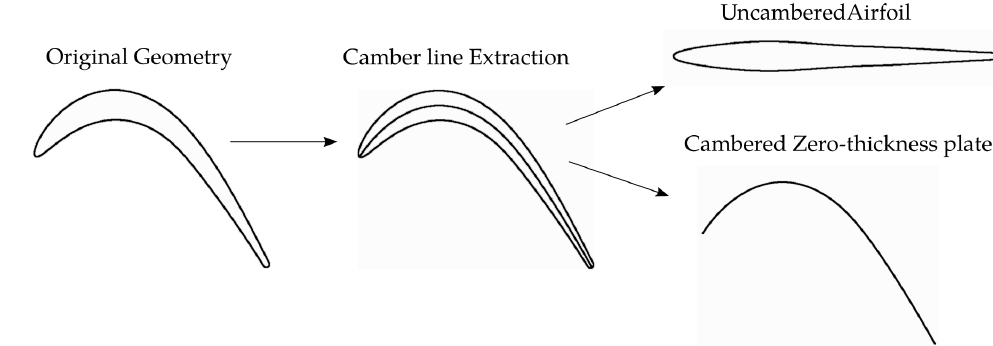
Figure 7. Extraction of the camber line from turbine airfoil and construction of cambered plate and uncambered airfoil with original thickness profile.